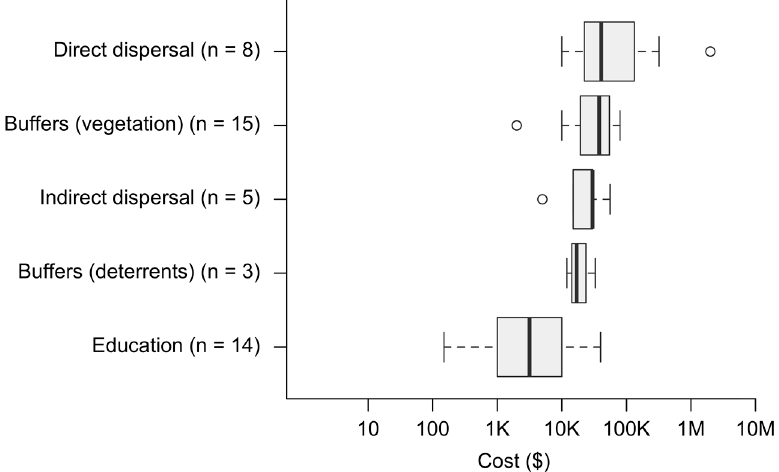
Figure 5. Box plots showing the quantiles and outliers for the comparative cost of management actions. Note that the x -axis is shown on the log scale to ensure all data are visible and ranges from $10 to $10,000,000.